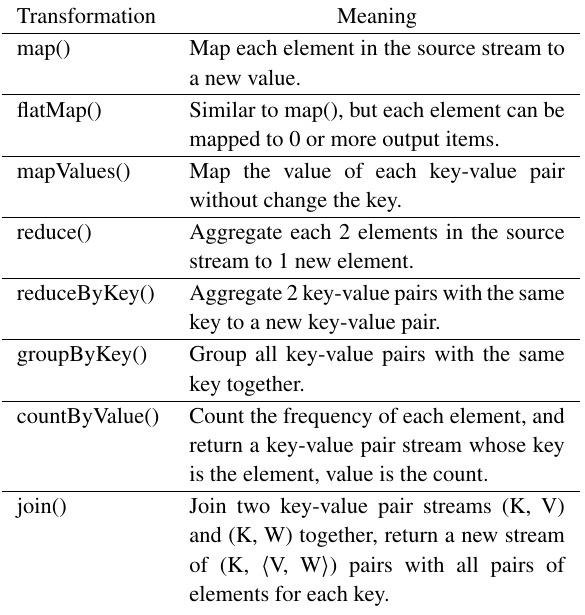
Table 1 Various useful transformation Spark Streaming